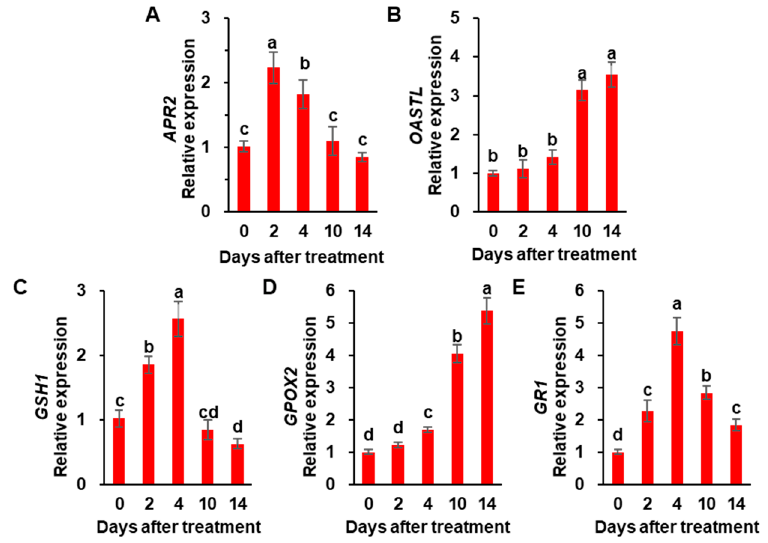
Figure 4. Relative expression of sulfate assimilation-related genes, adenosine-5-phosphosulfate reductase 2 ( APR2 , ( A )), O -acetylserine(thiol)lyase ( OASTL , ( B )), γ -glutamylcysteine synthetase 1 ( GSH1 , ( C )), glutathione peroxidase ( GPOX2 , ( D )) and glutathione reductase ( GR1 , ( E )) in leaves of drought-stressed plants for 14 days. The values in drought-stressed plants at day 0 were set to 1. Data are represented as means ± S.E. for n = 4. The different letters indicate values that ate significantly difference at p < 0.05 according to Duncan’s multiple range test.